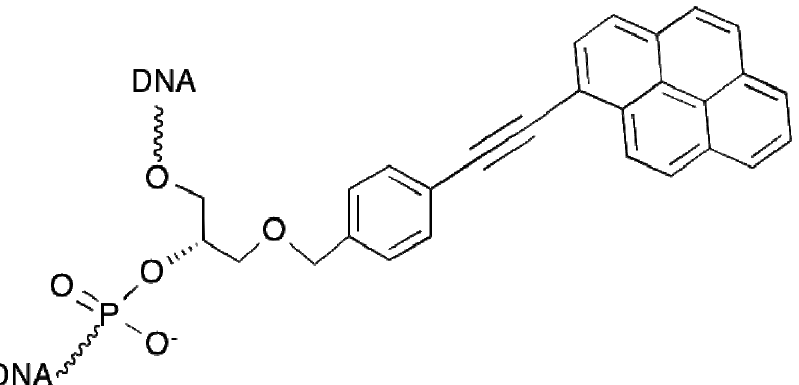
Figure 6. TINA (Twisted Intercalating Nucleic Acid)